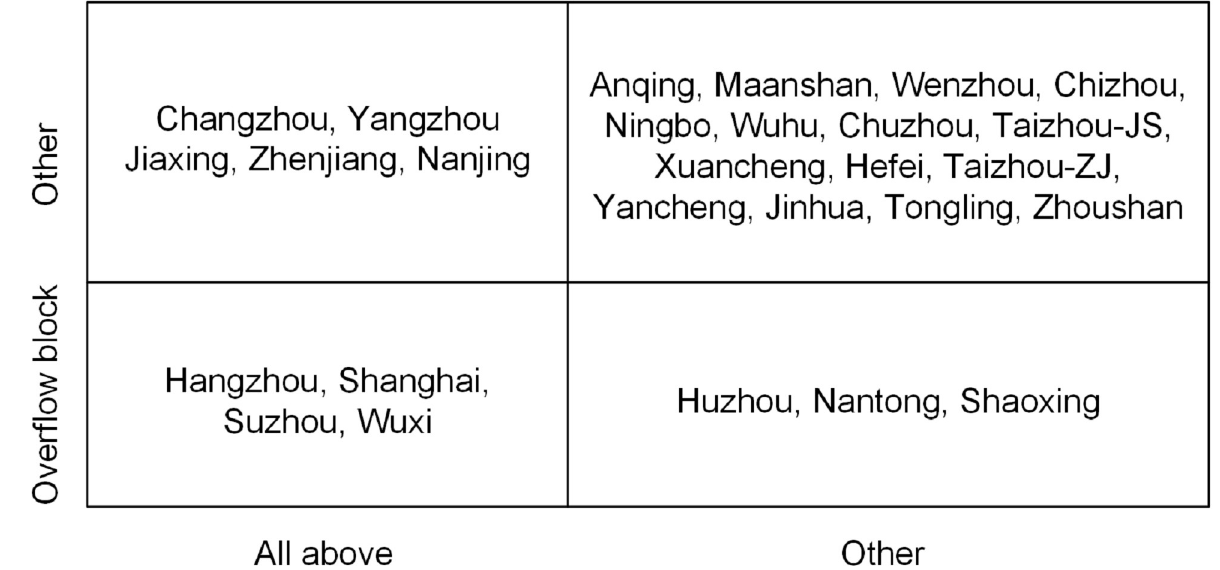
Fig 2. Classification of all above centrality and overflow block. All above mean that the city’s degree centrality, betweenness centrality and closeness centrality are all above the average level.